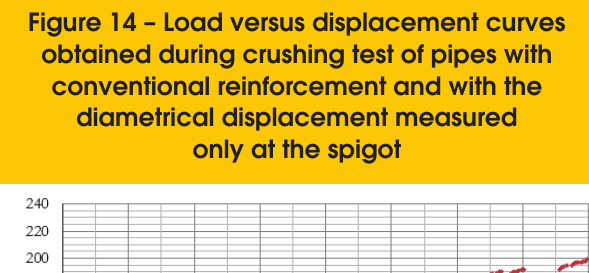
Figure 13 – Load versus displacement curves obtained during crushing test of pipes with 3 a fiber consumption of 40 kg/m and with the diametrical displacement measured only at the spigot